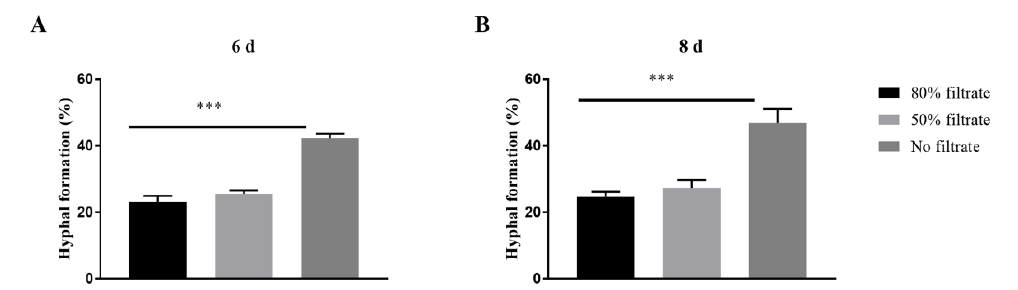
Figure 3. Effects of the spent medium on the hyphal formation in Ophiocordyceps sinensis when 10 5 blastospores per ml were inoculated in liquid PM medium after 6 days ( A ) and 8 days ( B ). p < 0.001 (***).